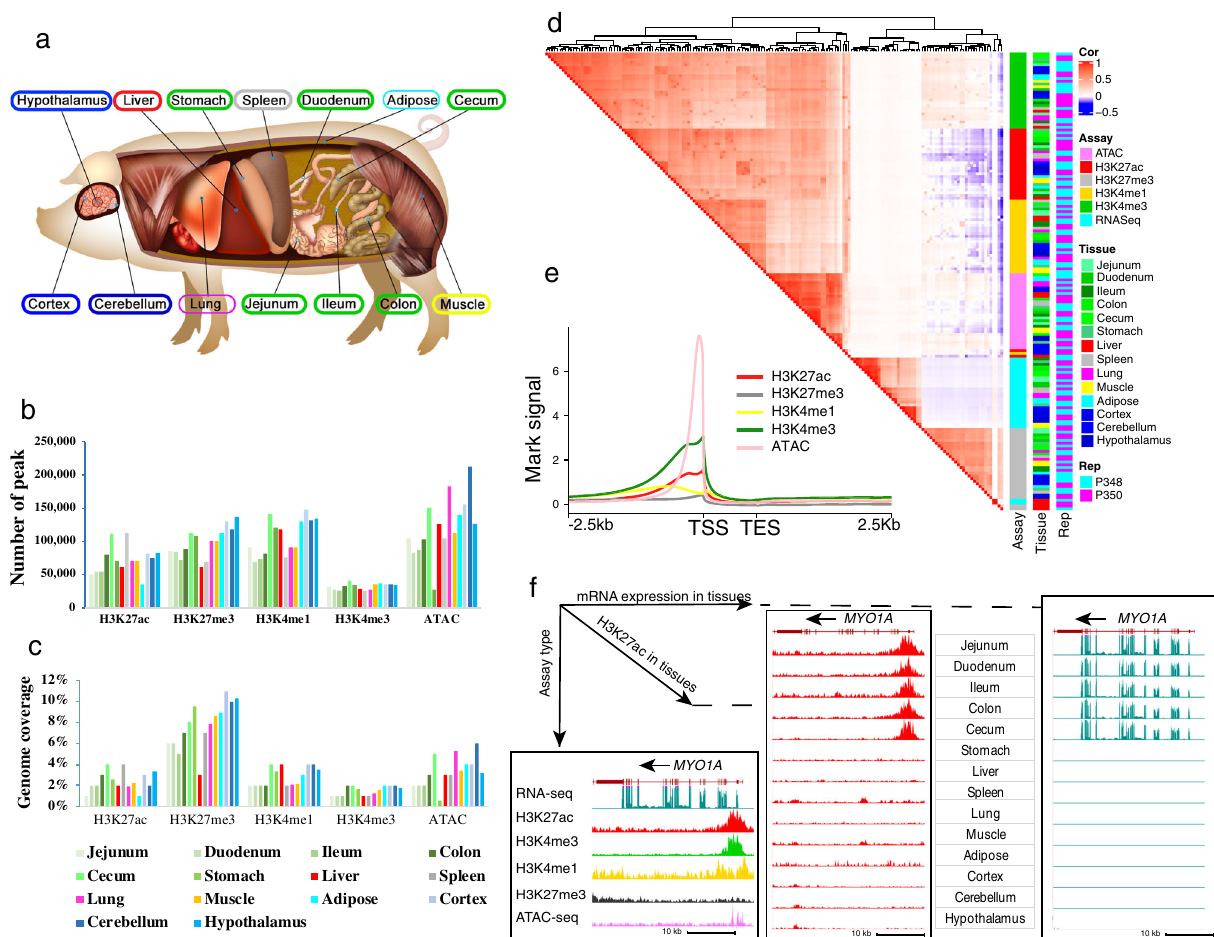
Fig. 1 Data summary of epigenomic information across tissues and marks. a Tissues assayed by this study . b , c Average peak number and genome coverage for each epigenetic mark in each tissue. d The Pearson correlations among assays, tissues, and biological replicates (P348 and P350) based on the normalized signal in 1 kb windows stepped across the whole genome. e Average epigenetic mark signal proximal to protein-coding genes. TSS transcription start site, TES transcription end site. f Epigenetic signal at the MYO1A locus according to different assays and in different tissues. Vertical scale of UCSC tracks shows normalized signal from 0 to 200 for RNA-seq, 0 to 100 for H3K27ac and H3K4me3, and 0 to 50 for other marks and ATAC-